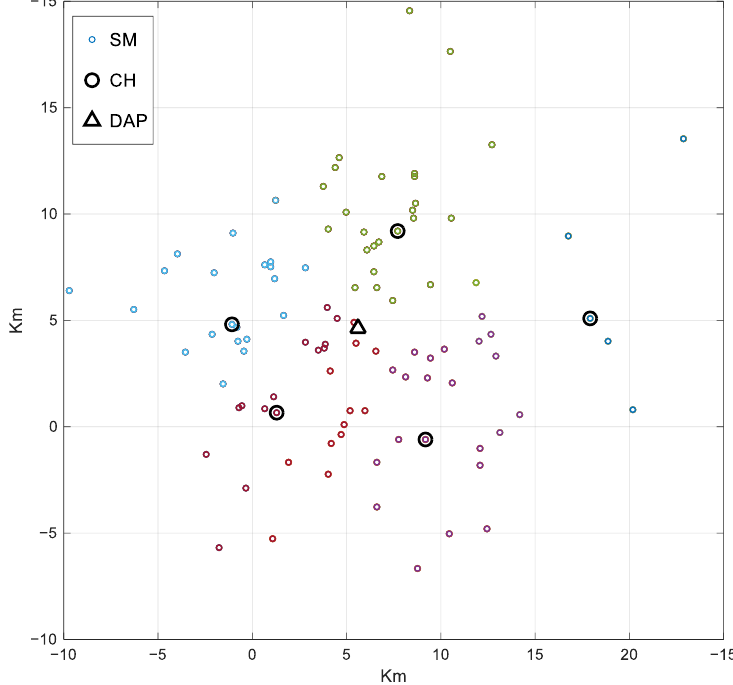
Figure 6. The result of clustering.